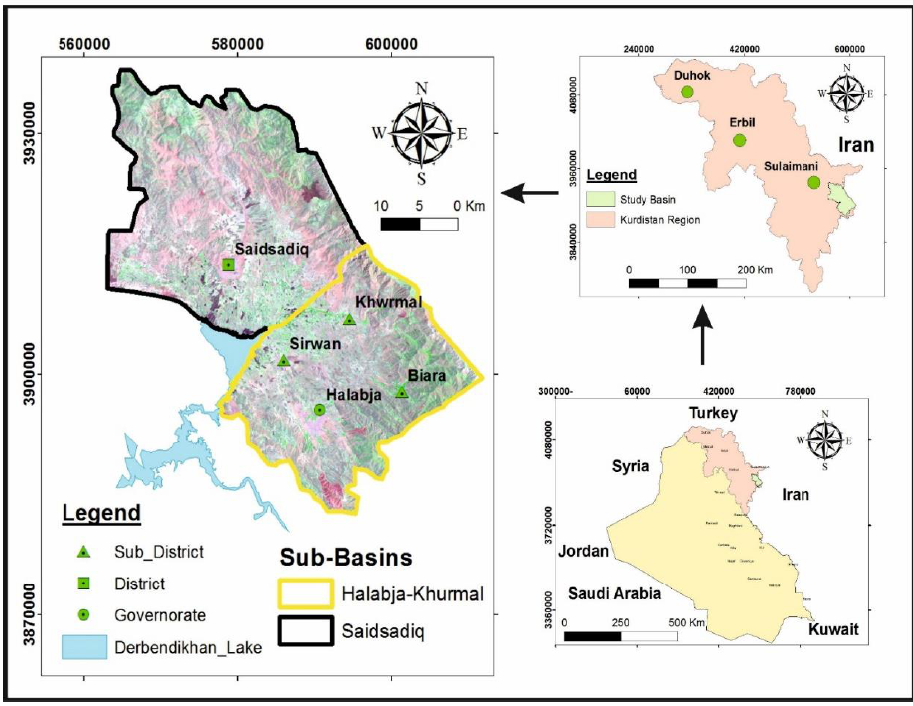
Figure 1. Location map of the Halabja Saidsadiq Basin (HSB).